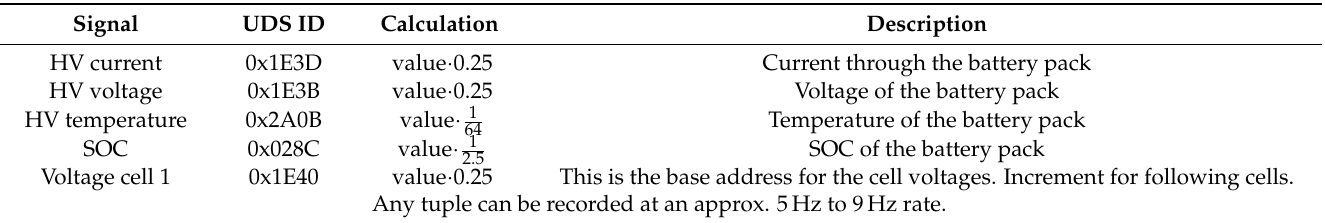
Table 2. UDS IDs for the used labels and factors to convert raw measurements ot physically meaningful values. These IDs can be queried from the battery management